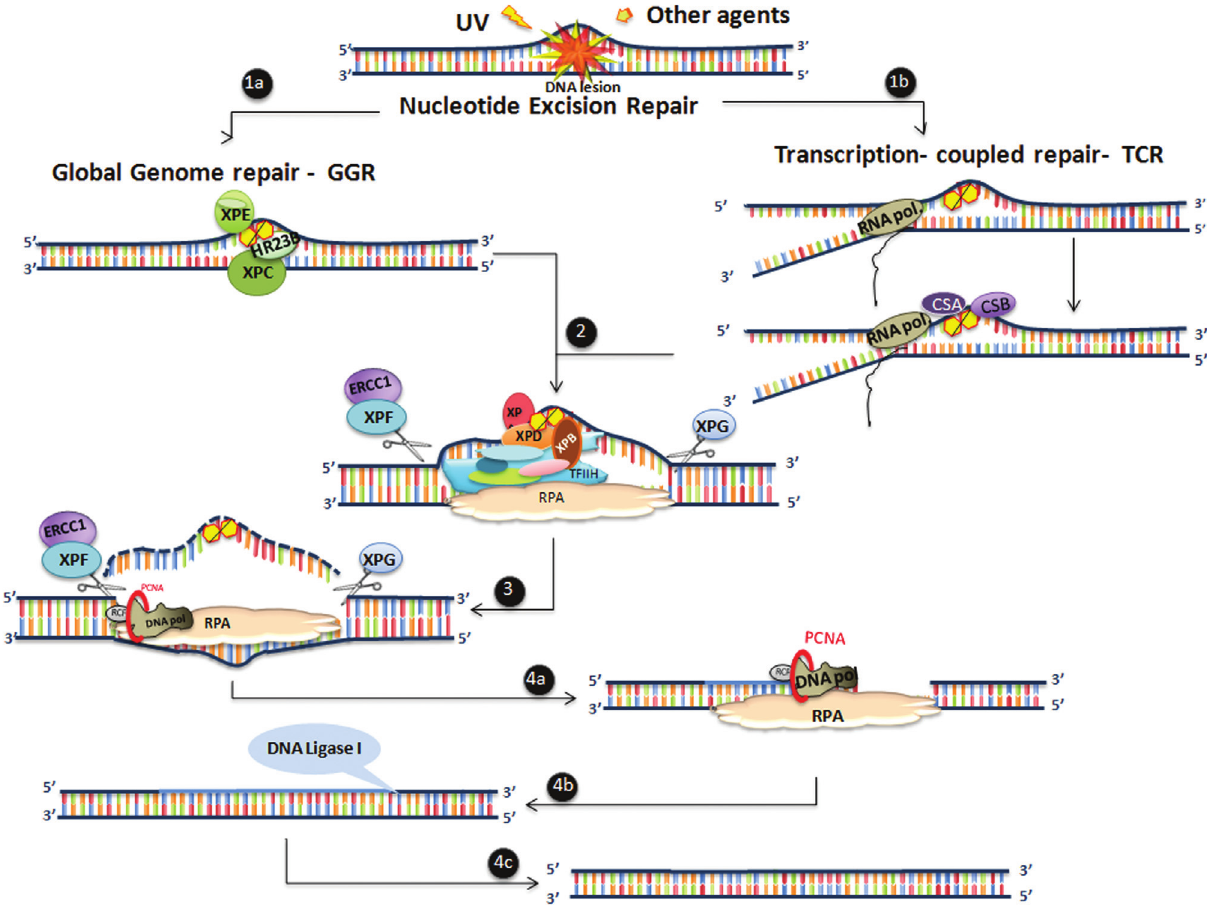
Figure 2 - Schematic representation of nucleotide excision repair (NER): the proteins associated with human diseases are highlighted. The downstream NER pathway and each of the sub-pathways (GGR and TCR) for lesion recognition are indicated, showing the different steps for DNA lesion removal in an error-free